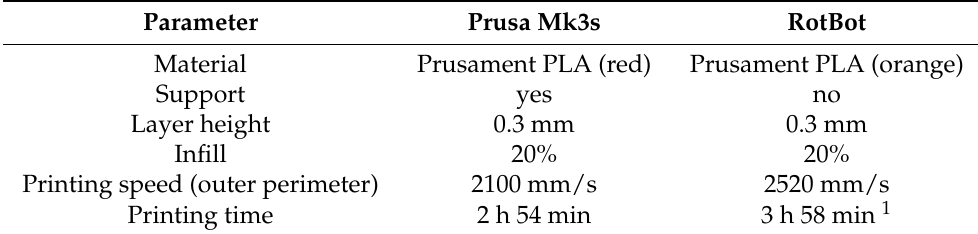
Table 1. Comparison of printer settings for reference prints.